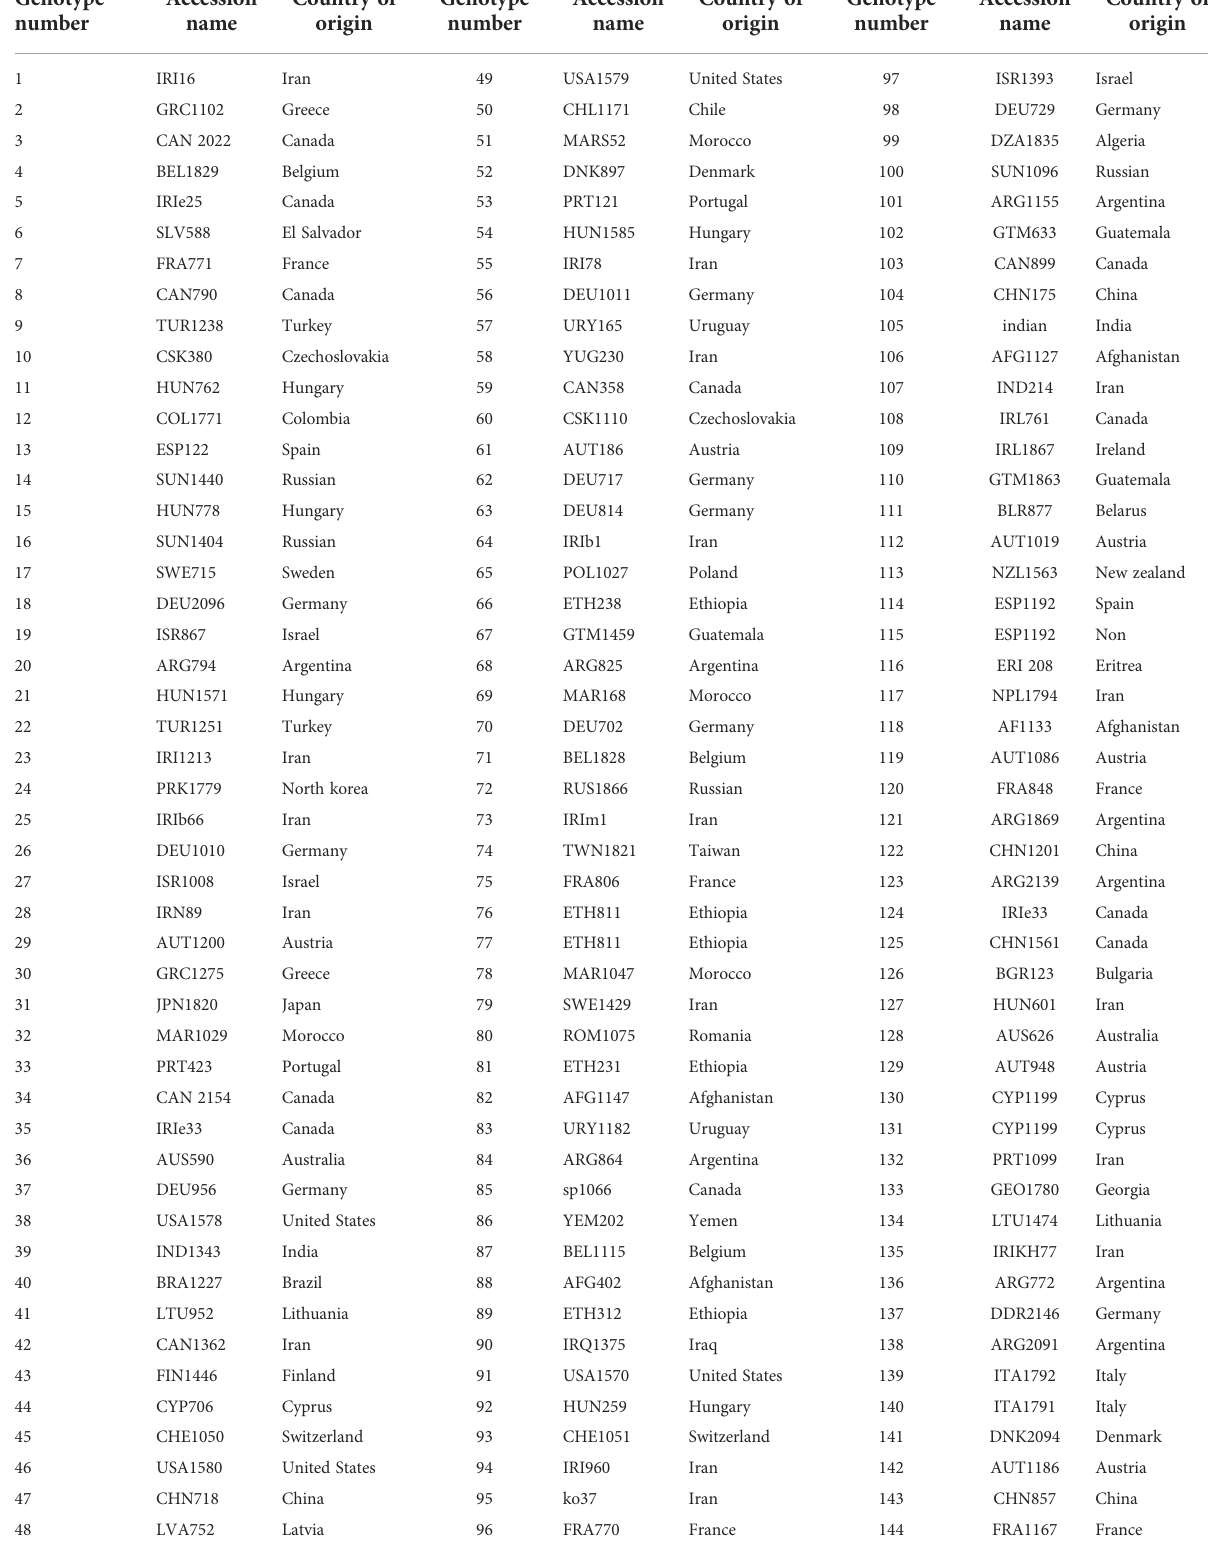
TABLE 1 Information on fl ax genotypes used in this